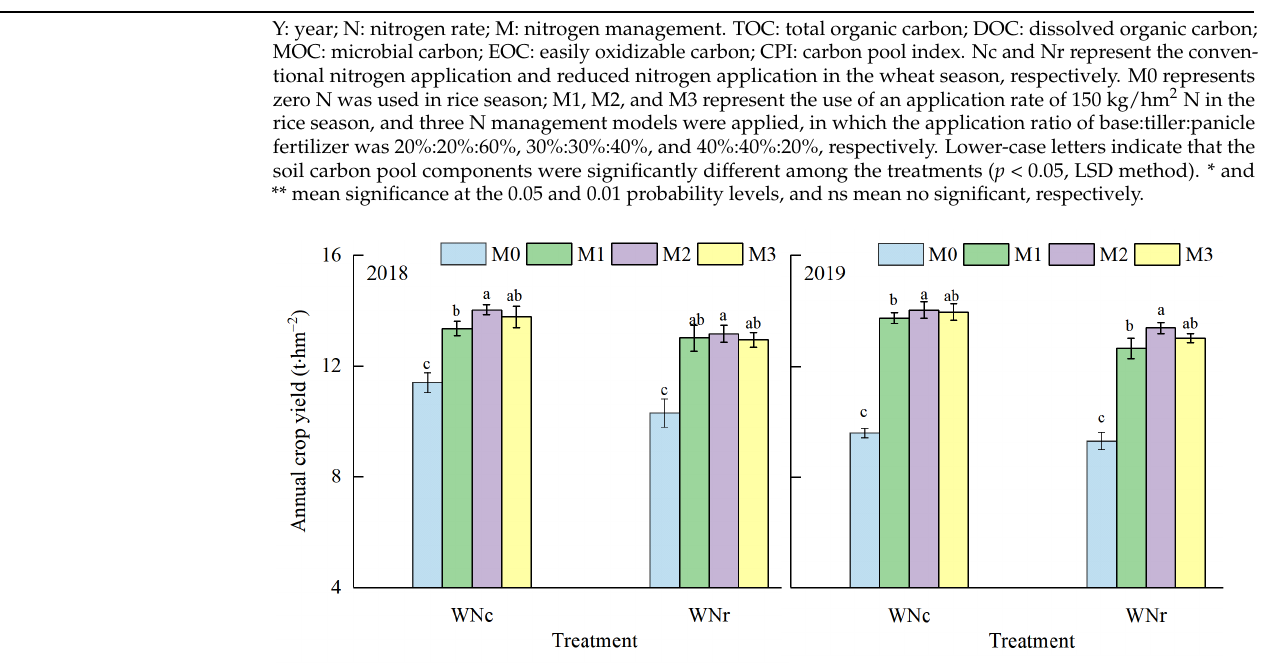
Figure 3. Effects of N management optimization in the rice season and N application rate in the wheat season on the crop yield . WNc and WNr represent the conventional nitrogen application